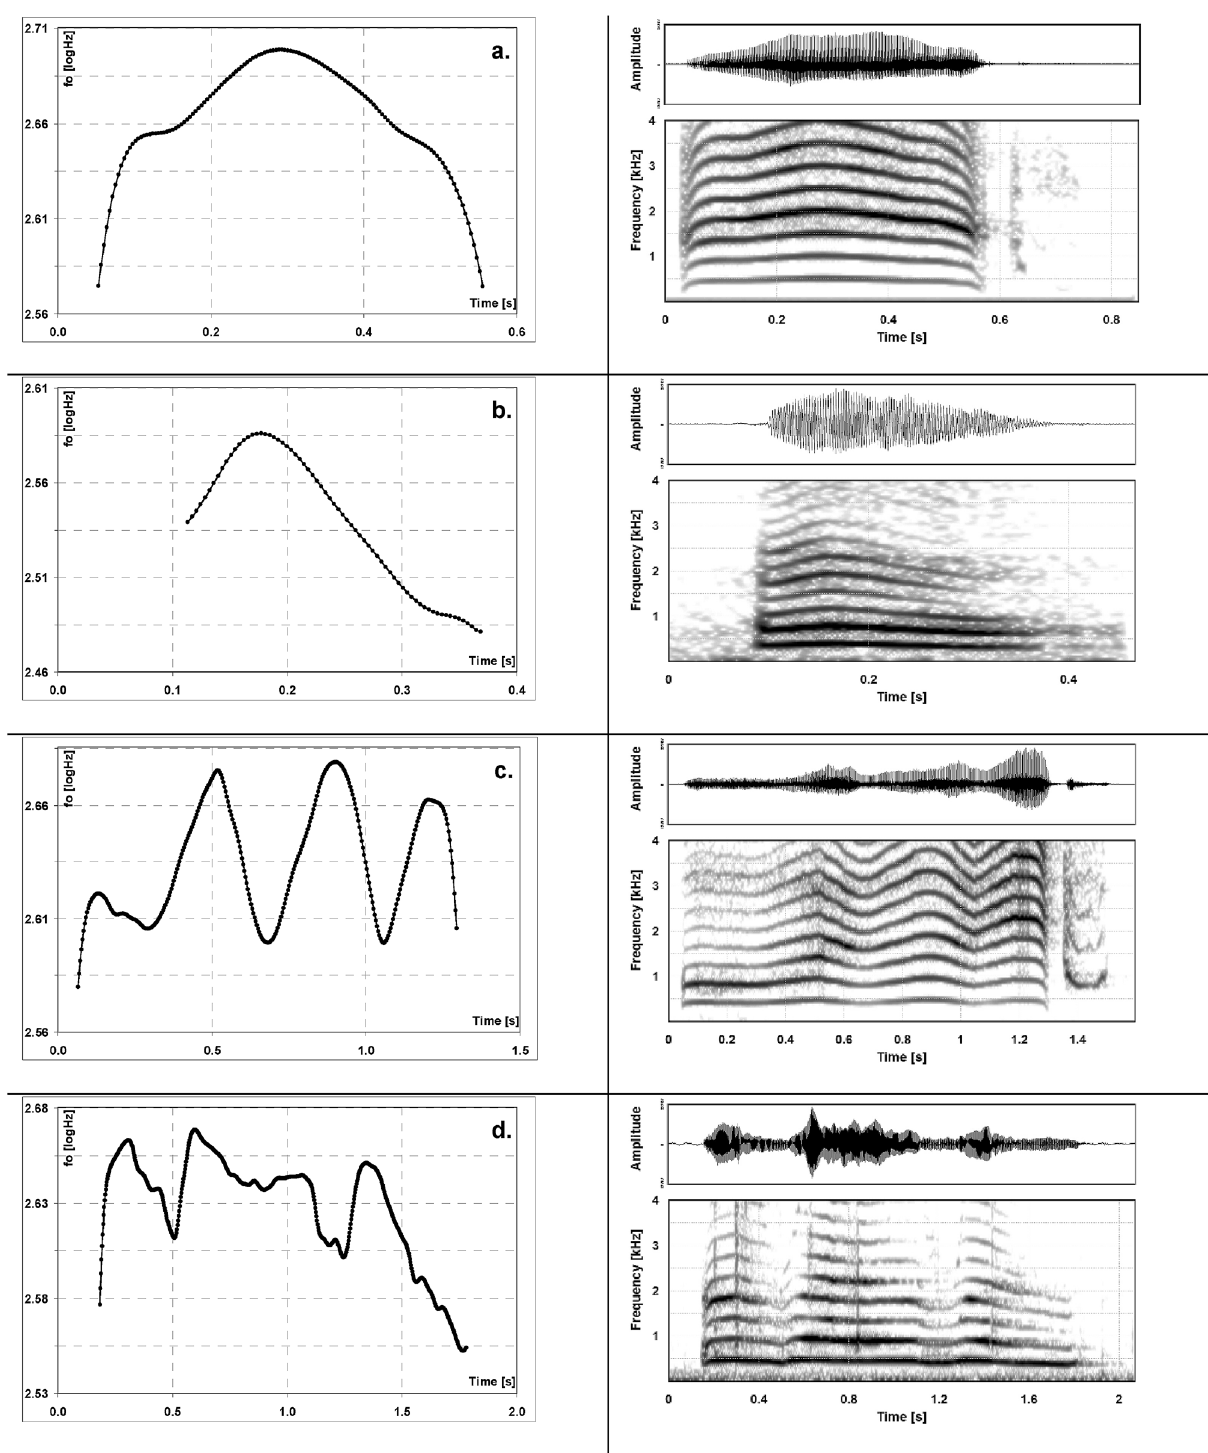
Figure 1. ( a – d ) Melody (fundamental frequency—fo) contour diagrams (left) exemplifying simple (a: cry, b: non-cry) and complex (c: cry, d: non-cry) patterns together with the corresponding frequency spectra (time representation above) of the sounds (up to 4 kHz). The frequency scale of the melody diagrams is logarithmic, and the diagram grid marks semitone (fo) vs. time distances. Note that spectra a. and c. also display the inspiratory noise following the vocalisation. For the original audio files of these vocalisations see Supplementary